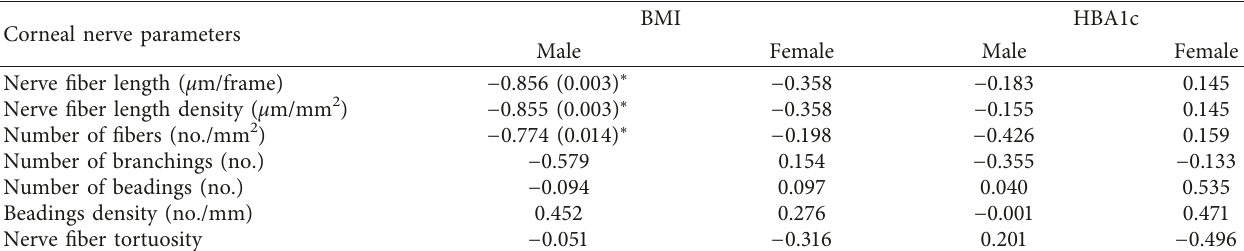
Table 7: Correlation r ( P < 0 . 05) of corneal parameters in the T1DM subgroup divided by sex and metabolic data. Corneal nerve